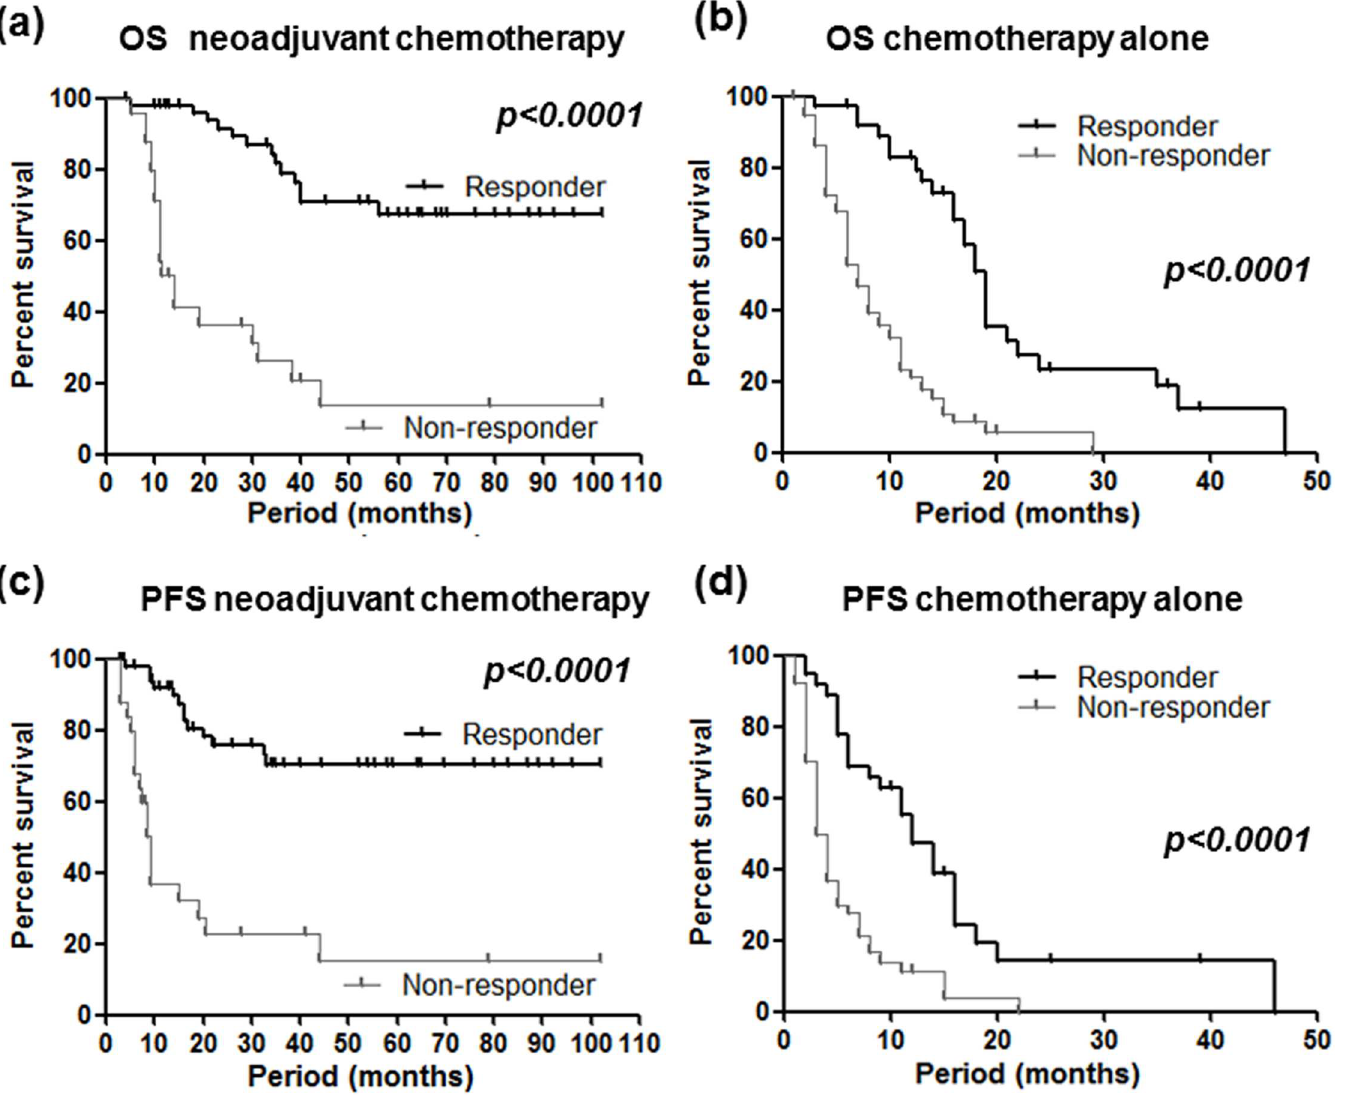
Fig 3. Overall survival (OS, upper) and progression-free survival (PFS, lower) in relation to the endoscopy based response evaluation. Left, patients performing neoadjuvantchemotherapy; right, patients performingchemotherapy alone; Different two groups was assessed using the Kaplan-Meier method and the Log rank